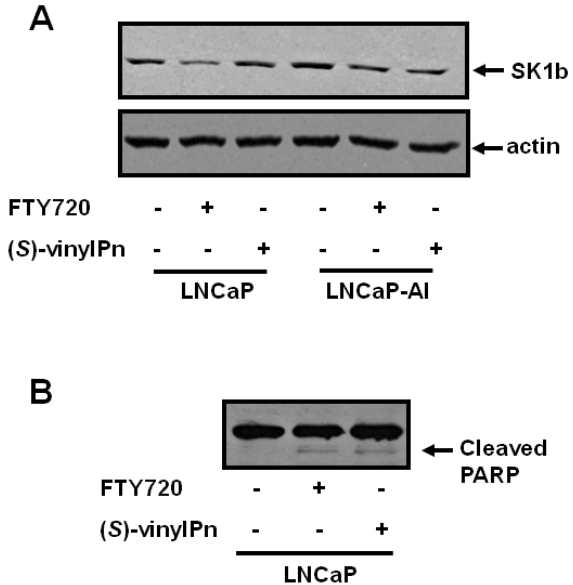
Figure 2. Effect of ( S )-FTY720 vinylphosphonate on SK1b expression and PARP cleavage in LNCaP and LNCaP-AI cells. LNCaP cells or LNCaP-AI cells were treated with FTY720 (10 μM, 48 h, for comparison), ( S )-FTY720 vinylphosphonate (10 μM, 48 h), or with vehicle (DMSO, 0.1% v/v, 48 h) alone. The lysates were subjected to western blot analysis with ( A ) anti-SK1b antibody (for comparison the effect of ( S )-FTY720 vinylphosphonate and FTY720 on SK1b expression is shown in LNCaP-AI cells), or ( B ) anti-PARP antibody. Results are representative of at least 3 separate experiments. ( S )-vinylPn represents ( S )-FTY720